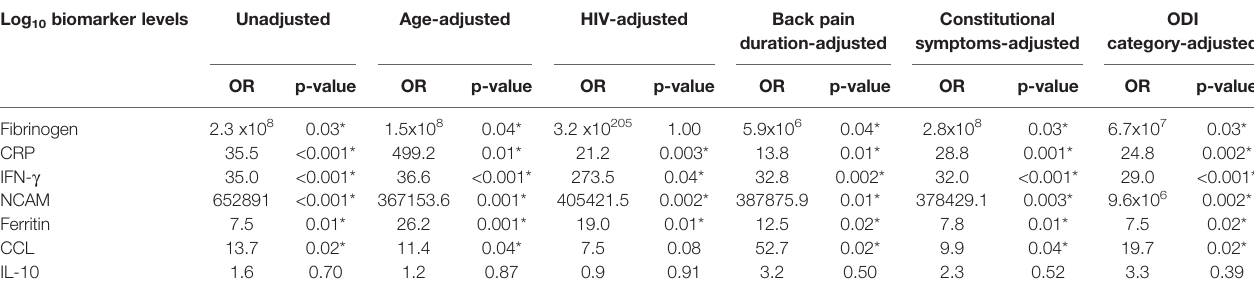
TABLE 5 | Association between spinal tuberculosis and selected biomarkers following adjustment for a demographic or clinical variable. Log 10 biomarker levels